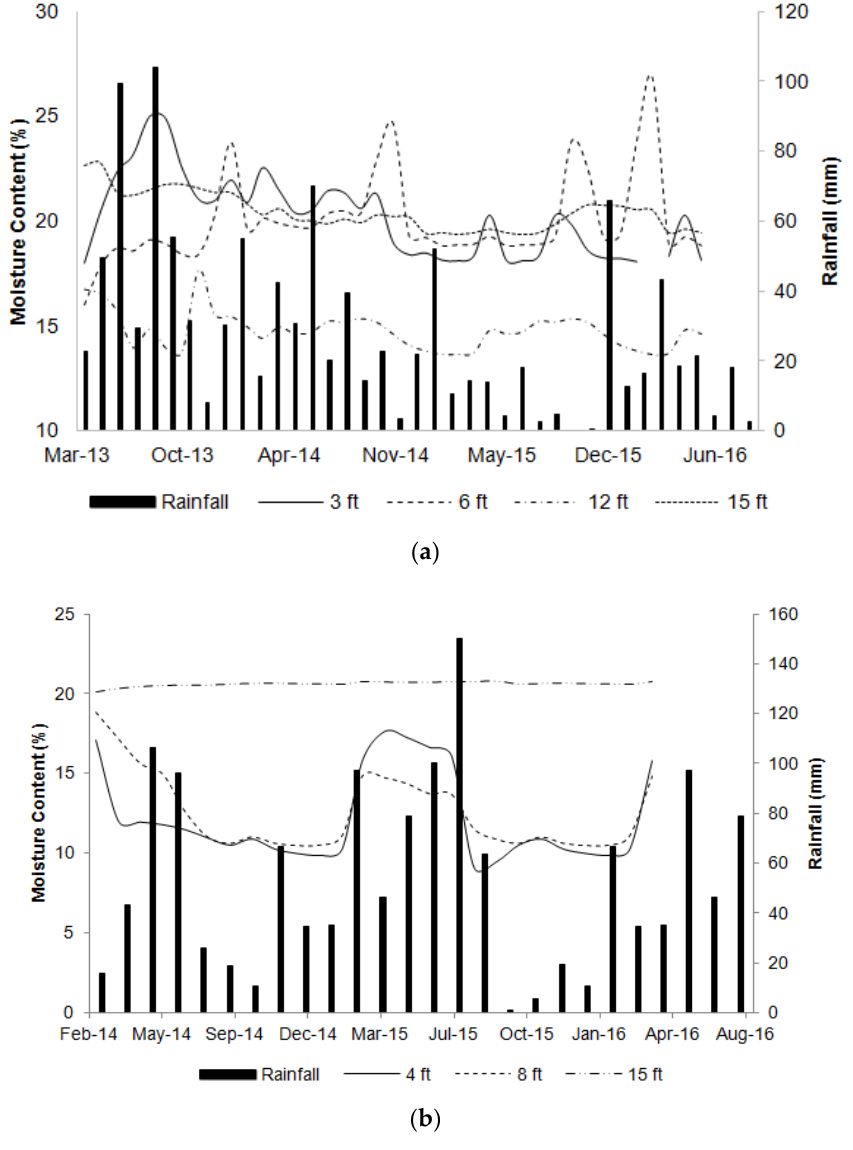
Figure 2. Moisture variation in ( a ) FM 2757 site and ( b ) SH 342 site.